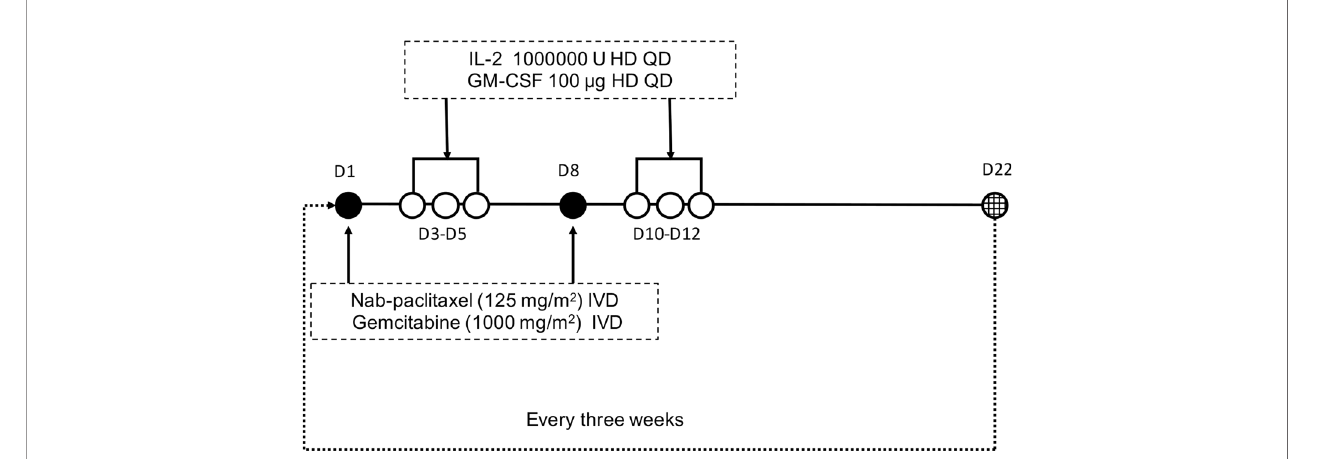
FIGURE 1 | Protocol of drug administration. Nab-paclitaxel (125 mg/m 2 ) and gemcitabine (1000 mg/m 2 ) were administered intravenously to all patients on days 1 and 8 triweekly. Interleukin-2 (10000000 U) and GM-CSF (100 µg) were administered subcutaneously on days 3-5 after chemotherapy.